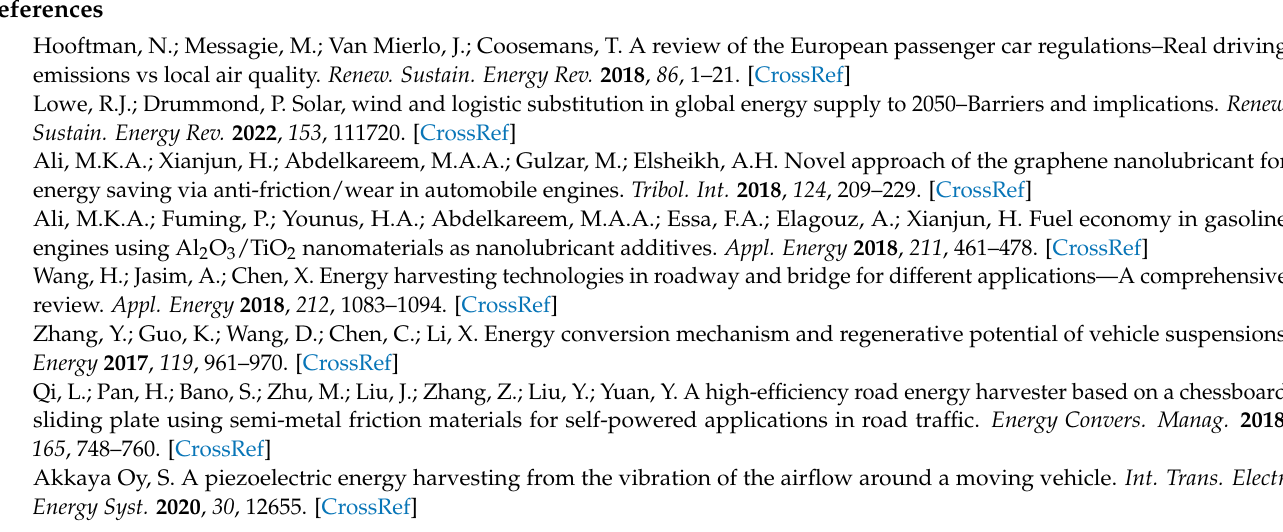
frequencies. Figure S5: (a) Voltage of the PZT 1-4. (b,c) rectified voltage and current. Support